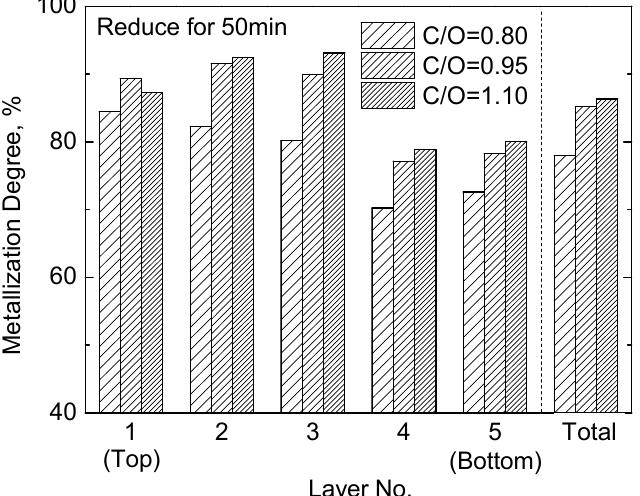
Figure 7. Effect of C/O on metallization degree of direct reduced iron (DRI).